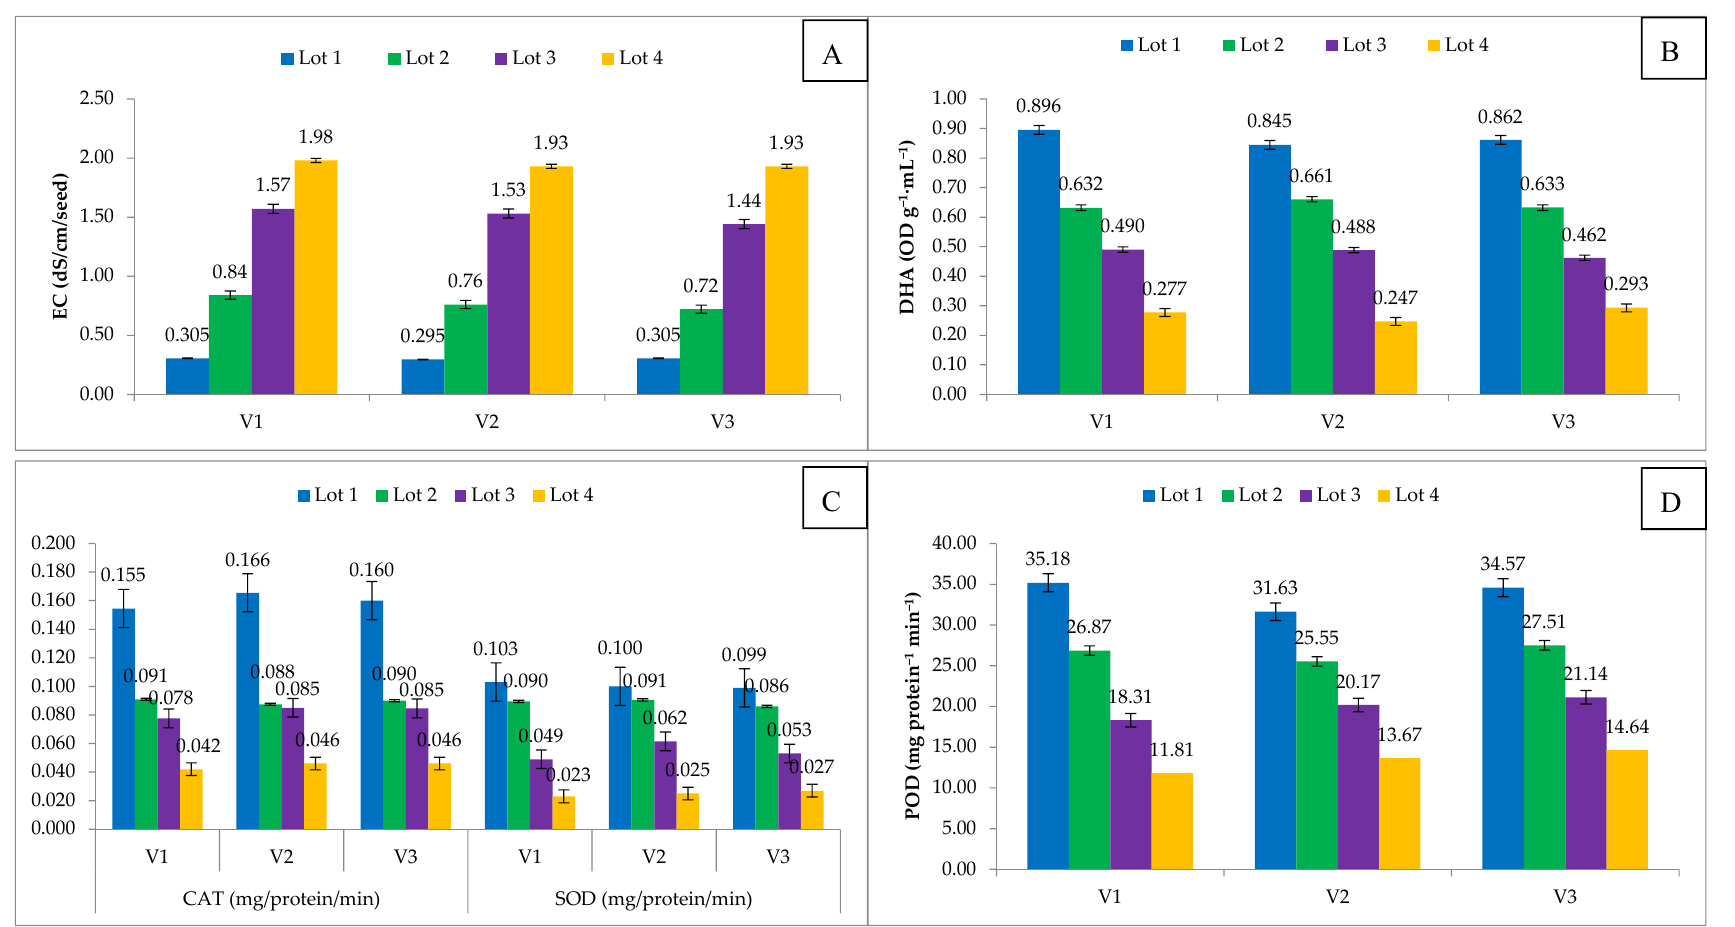
Figure 5. Effect of seed ageing on ( A ) Electrical conductivity; ( B ) DHA activity; ( C ) CAT and SOD activity; ( D ) POD activity. V 1 —Hisar-2; V 2 —Hisar Onion-3; V 3 —Hisar